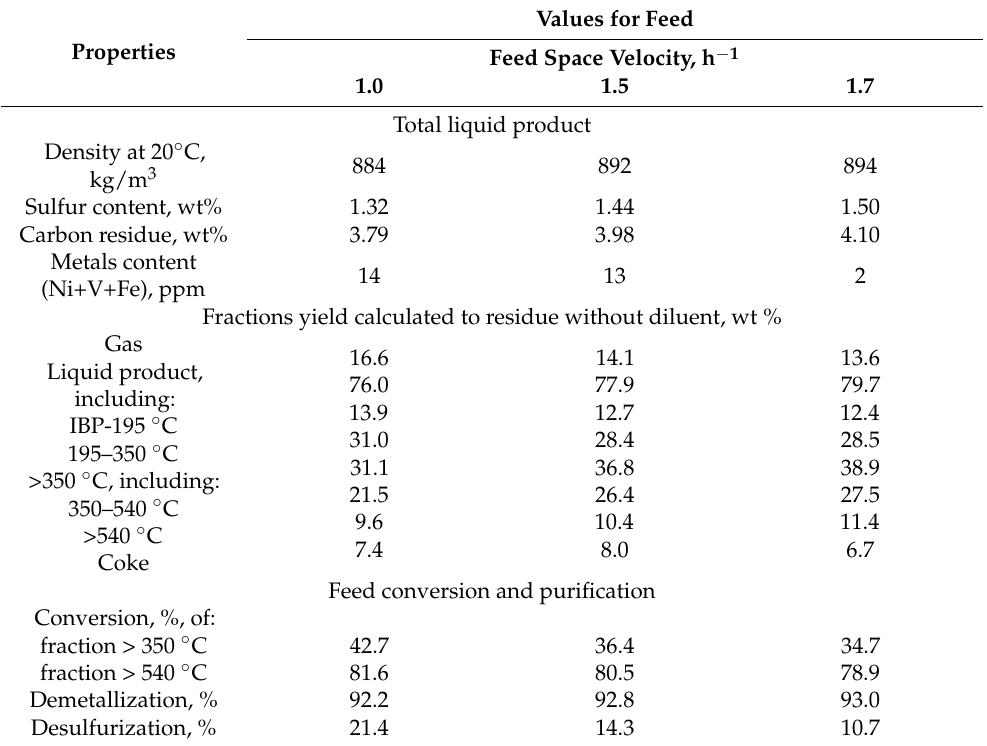
Table 4. Characteristics of the total liquid product of adsorptive treatment at 485 ◦ C (Feed—AtmR (70 vol%) + SRGO (30